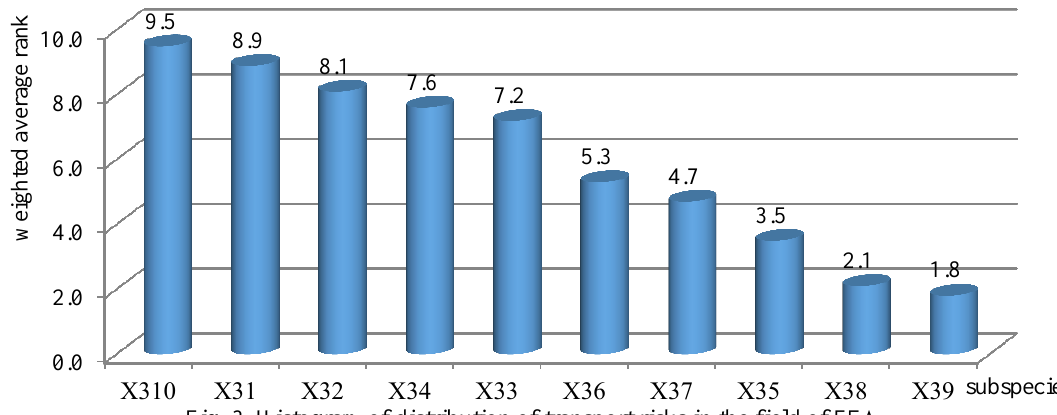
Fig. 3. Histogram of distribution of transport risks in the field of